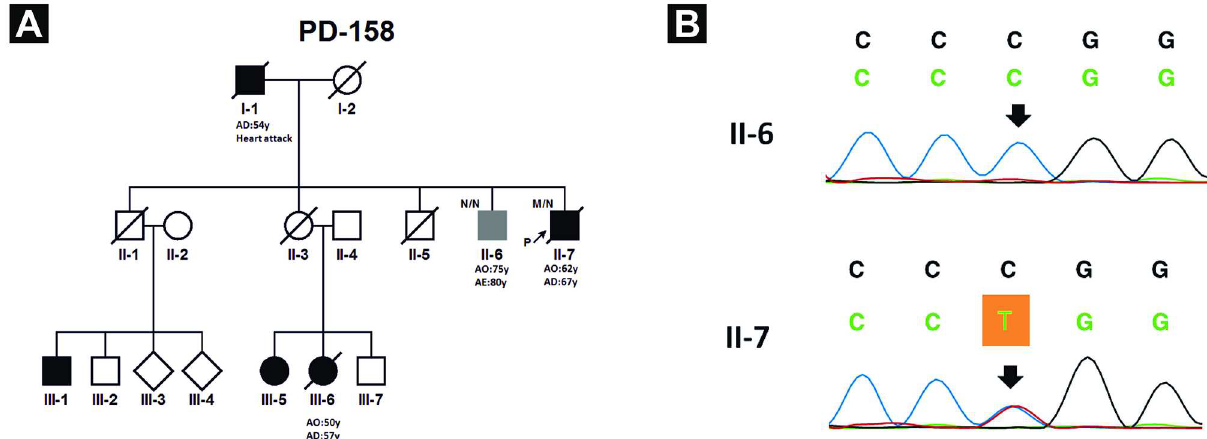
Fig 1. PD-158familypedigreeand sequencingchromatograms. (A) The arrow indicatesthe proband. Black filled symbols: patients affected with FTD;grey symbol:Alzheimer’s disease, white symbols:unaffected family members,N: normal,M: the p.P636L mutation, AO: age at disease onset,AD: age of death (B) Sequencing chromatograms of patientsII-6and II-7 showing the MAPT p.P636L mutationregion. S1 Table. In addition, we determined two patients with C9ORF72 variants: c.1138T > G (p. F380V) and c.146C > G (p.T49R) (S2 Table). The former variant was identified in a Turkish